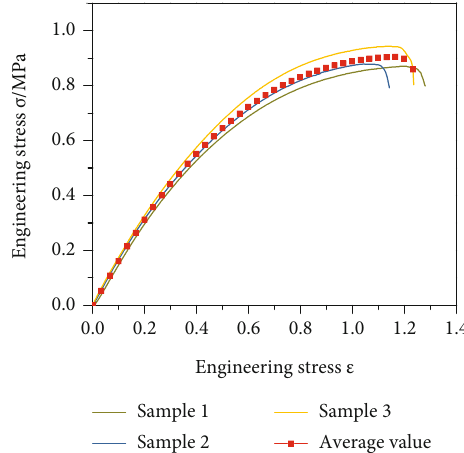
Figure 5: Uniaxial tensile stress-strain curves (2 MPa, 10mm/min).